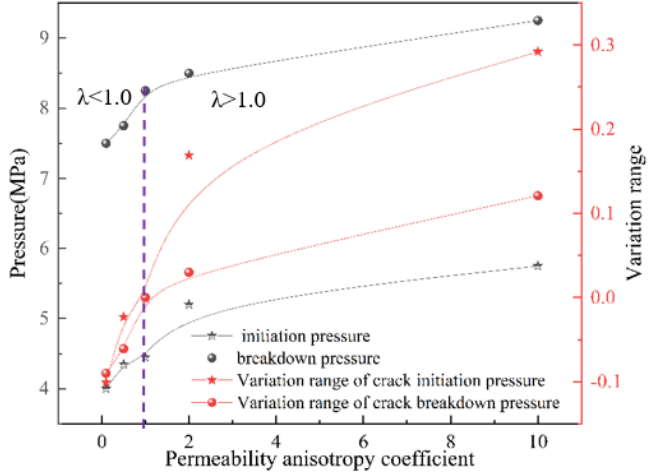
Figure 14. The variation law of crack initiation stress, fracture stress and their variation amplitude with the permeability anisotropy coefficient when ξ = 0.5.